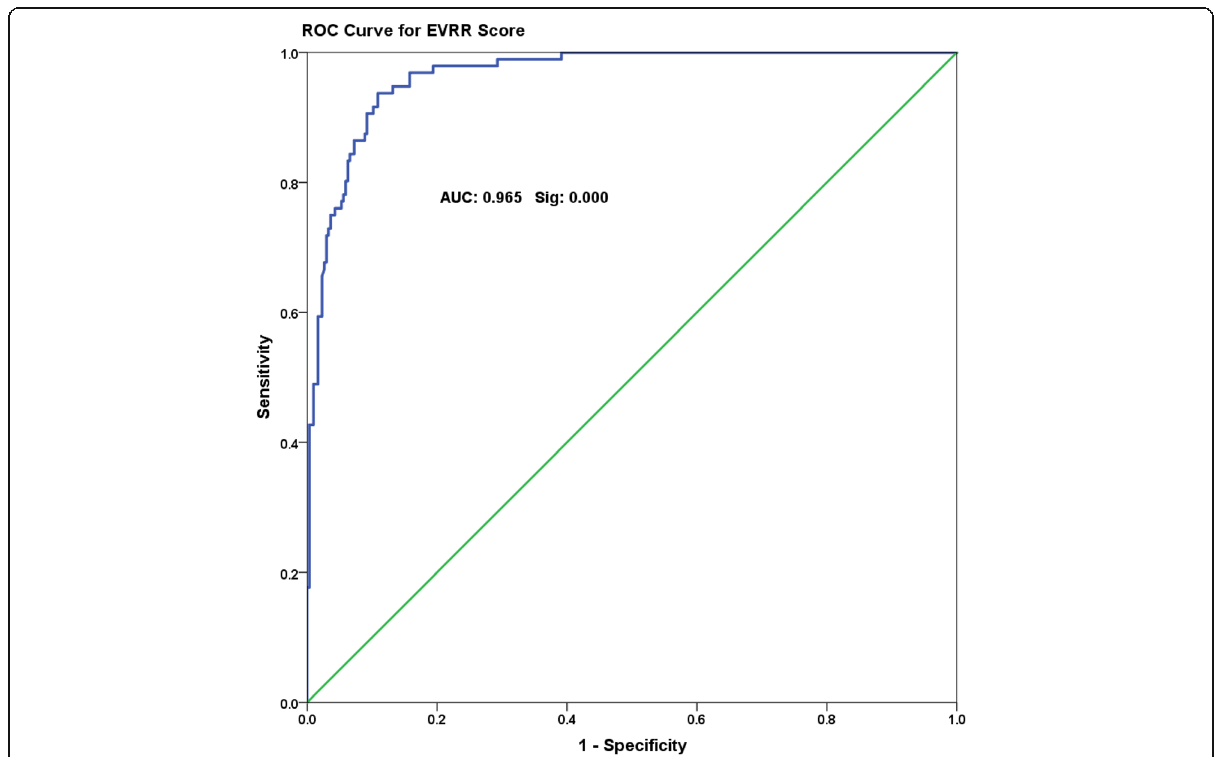
Fig. 2 ROC curve for early variceal rebleeding risk score